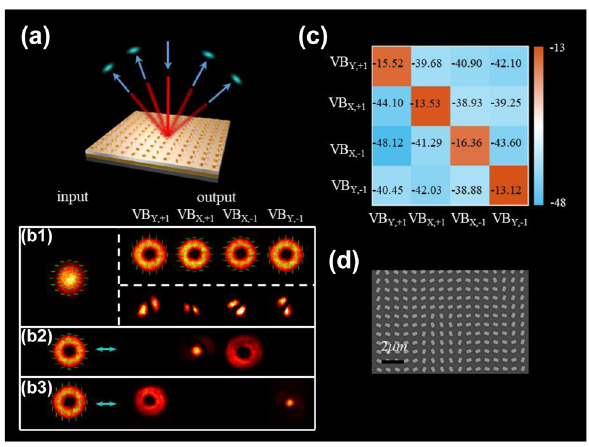
Figure 3: Optical performance of the metasurface-based (de)multiplexer. (a) Optical performance testing system diagram. (b1)–(b3) Polarization and intensity distributions in each diffraction order under different incident beams. (b1) Gaussian beam ( x -polarization); (b2) VB with l = 1 ( x -polarization); (b3) VB with l = − 1 ( y -polarization). (c) The light intensity at the center of each diffraction order under different OAM beams. (d) FE-SEM images of the fabricated (de)multiplexer. The scale of the picture is 2 μ